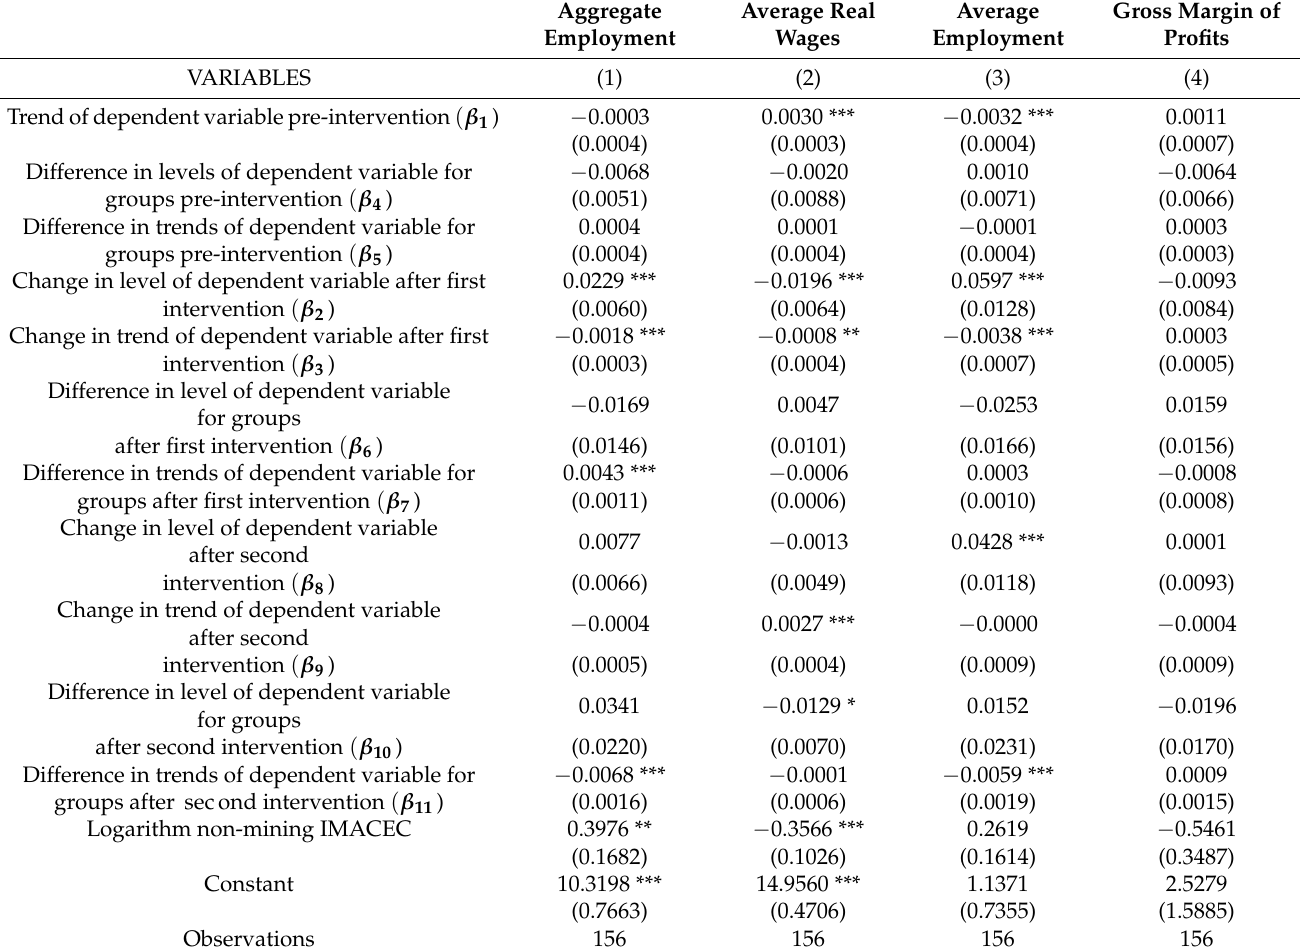
Table 2. Changes in labor market and firms’ profit outcomes after two stages of FOP